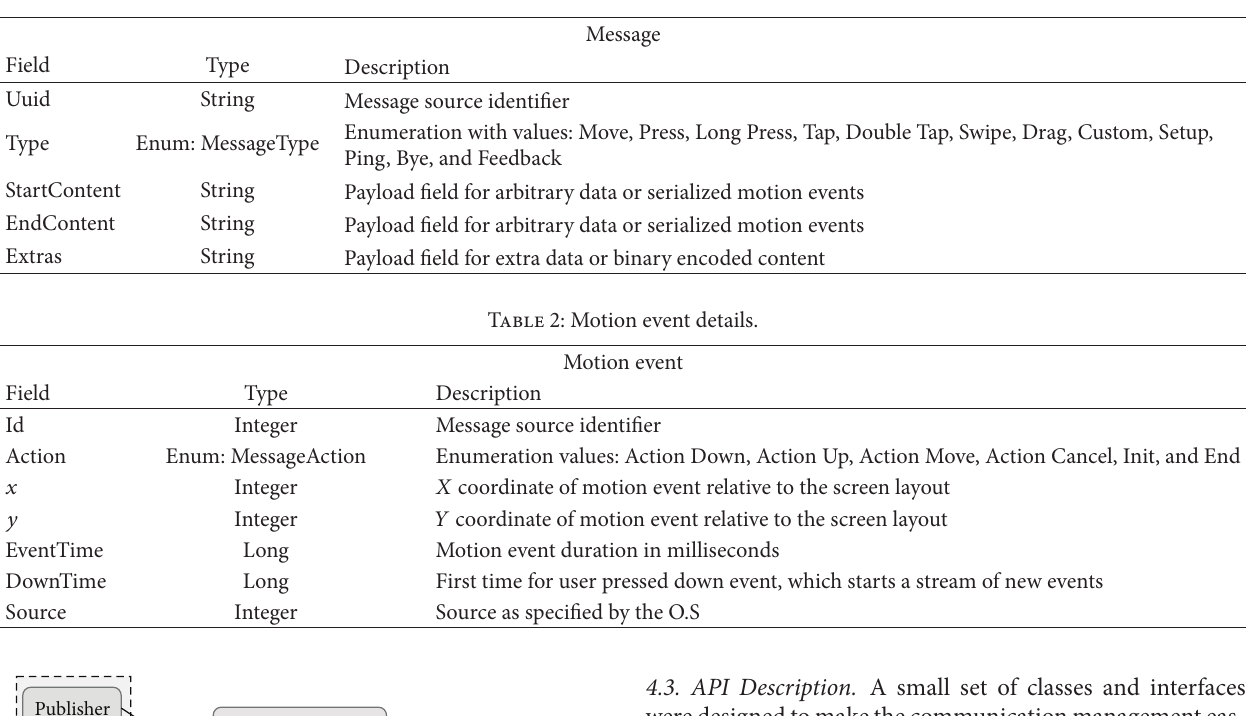
Table 1: Message details.